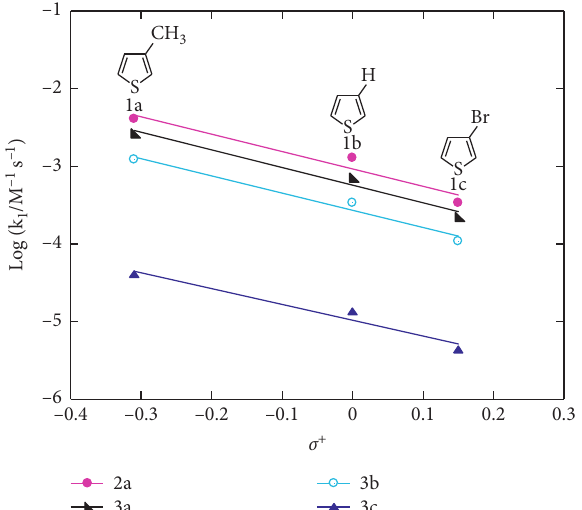
Figure 5: Hammett correlations: influence of the nature of the substituent X on the constant k thiophenes 1a-c with electrophiles 2a and 3a-c in acetonitrile at 20 ° C.